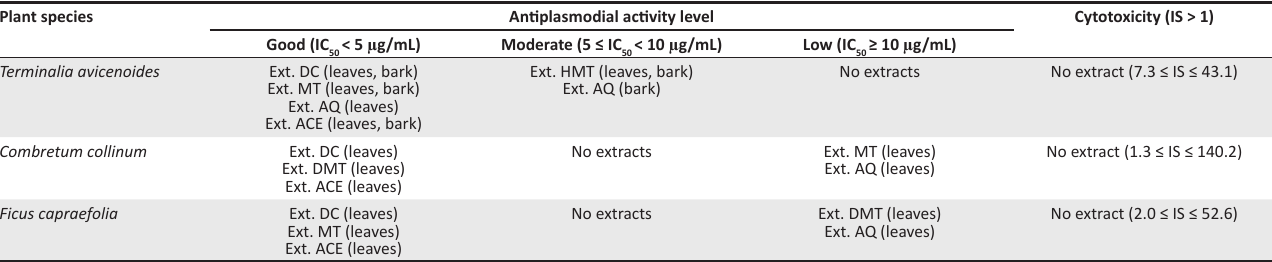
TABLE 2: Promising crude extracts from medicinal plants according to antiplasmodial activity level and cytotoxicity. Plant species Antiplasmodial activity